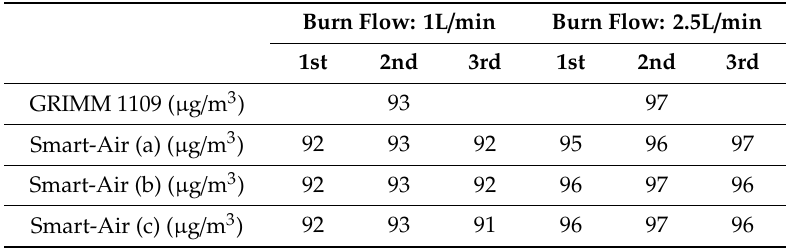
Table 1. Measurements from the reliability test of the laser dust sensor.